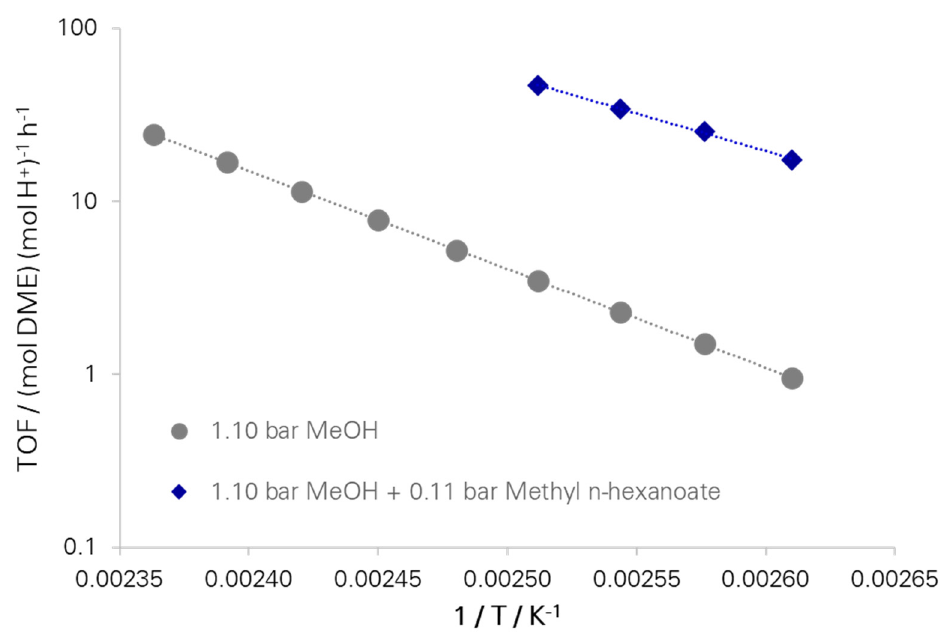
Figure 5. Arrhenius plot for H-ZSM-5 SAR80 with methanol-only feed and methanol plus methyl n -hexanoate feed. Conditions: methanol—WHSV 17.1 h − 1 ; methanol partial pressure—1.10 bar; ester partial pressure—0.11 bar; temperature range—110 to 150 °C for the methanol-only feed and 110 to 125 °C for the ester-containing feed.